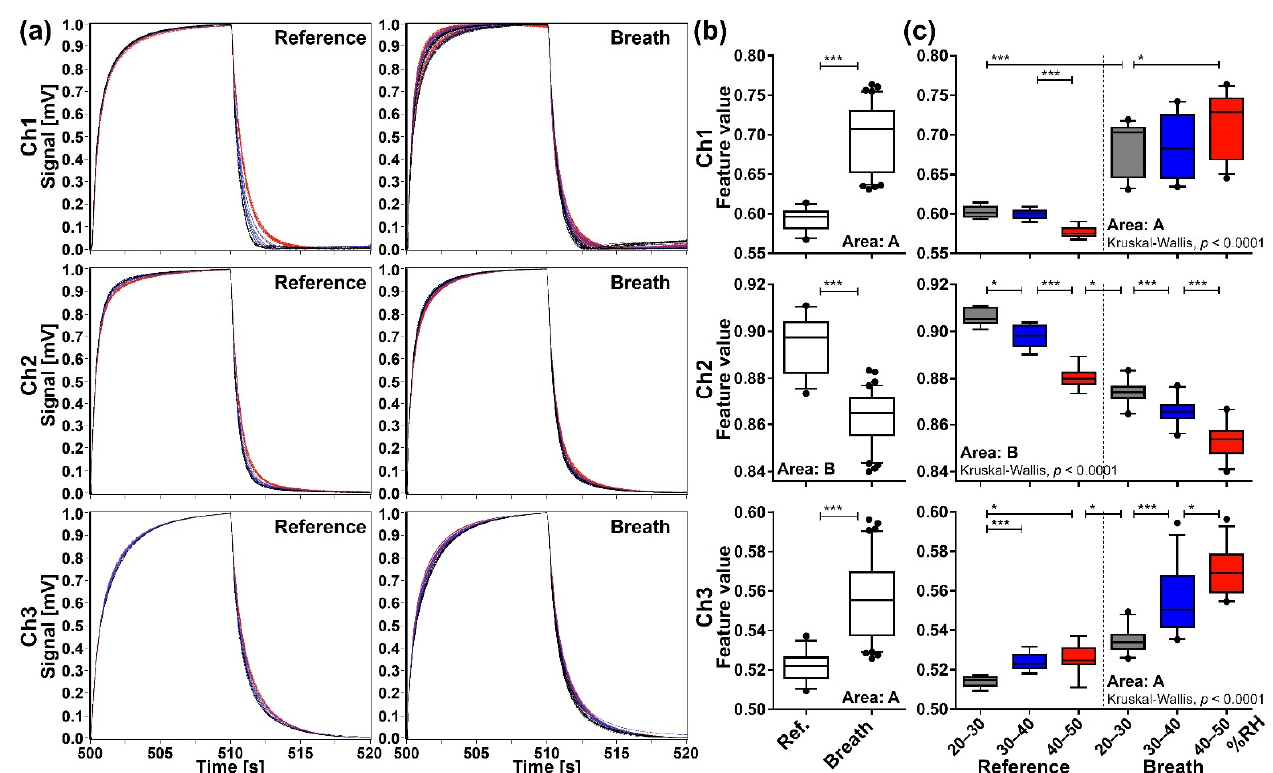
Figure 7. Sensing data processed by the min-max normalization method. ( a ) The waveforms of reference ( n = 33) and breath ( n = 83) samples. ( b ) Comparison of feature values between reference and breath samples evaluated by the two-tailed Mann-Whitney U test (***, p < 0.0001). ( c ) Comparison of feature values among subgroups categorized by RH range of the purge gas: grey for 20–30% RH (reference n = 10, breath n = 24); blue for 30–40% RH (reference n = 12, breath n = 25); and red for 40–50% RH (reference n = 11, breath n = 34). Box plots represent the results of Kruskal-Wallis test and post-hoc Mann-Whitney U test with Bonferroni correction (*, p < 0.01; ***, p < 0.0001).